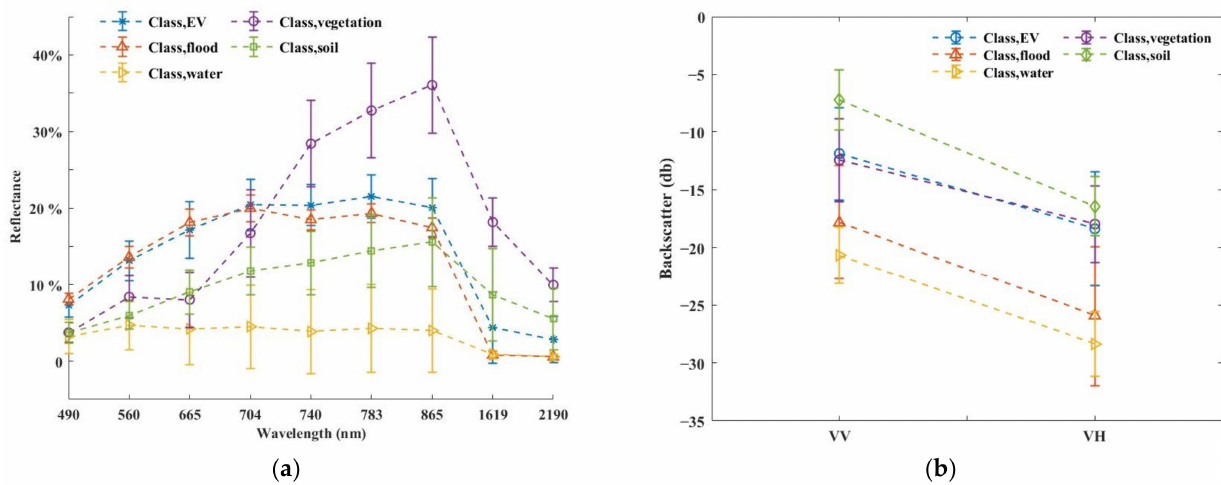
Figure 5. ( a ) Spectral profile (average and standard deviation) ( b ) VV and VH backscattering of the classes (EV: Emergent Vegetation, Flood: flood (turbid) water, Water: clear water, vegetation, and soil) included in the training dataset for Random Forest classification (the 2020